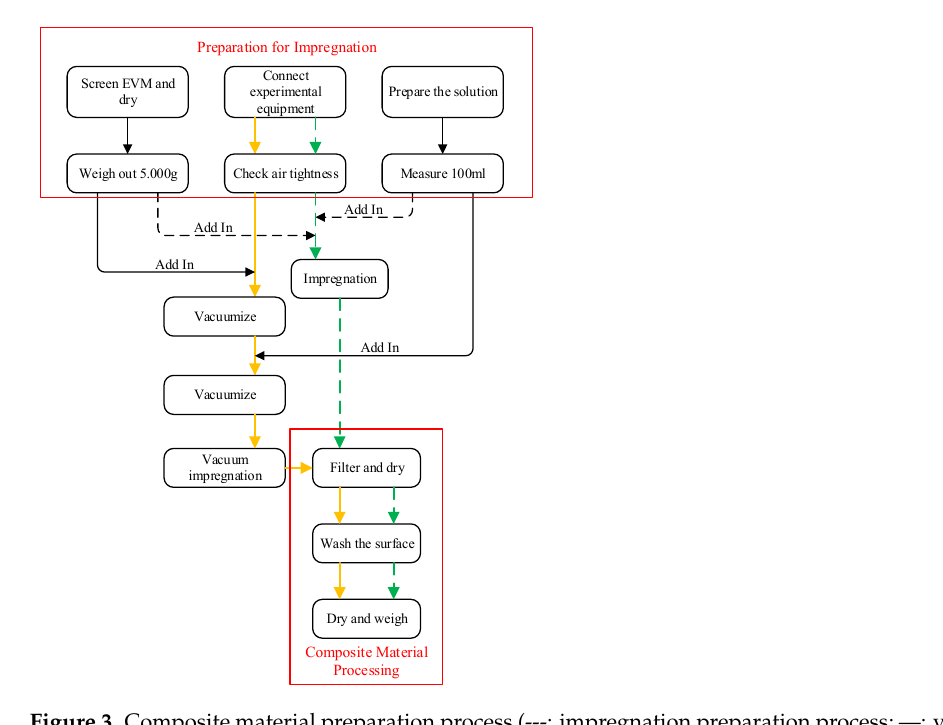
Figure 3. Composite material preparation process (---: impregnation preparation process; —: vacuum impregnation preparation process).